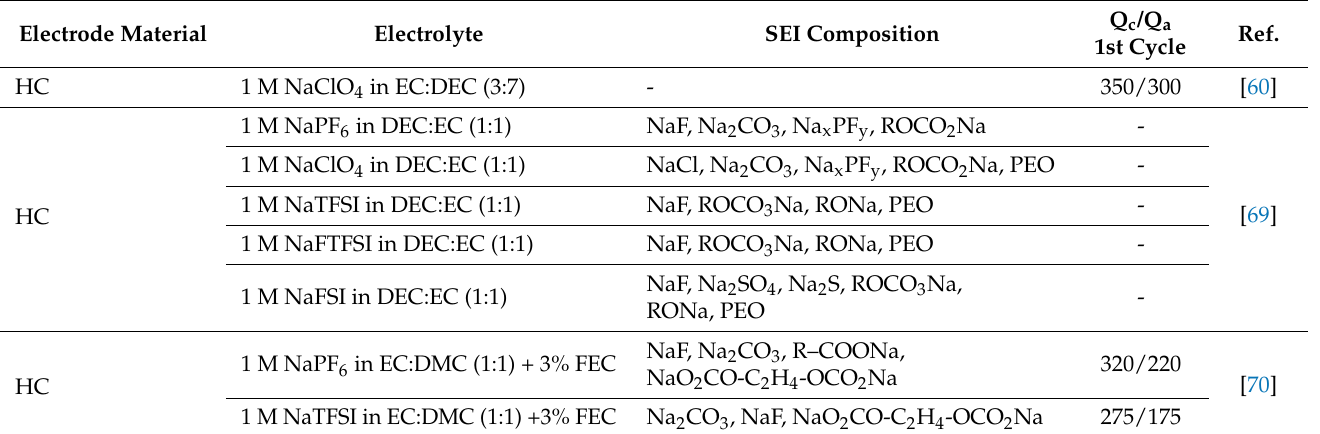
Table 1. SEI composition and irreversible capacity at the first